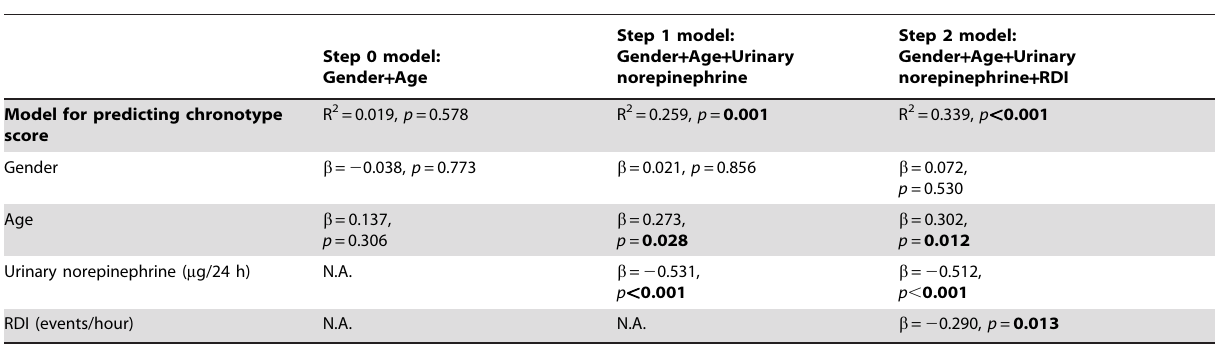
Table 5. Multivariate